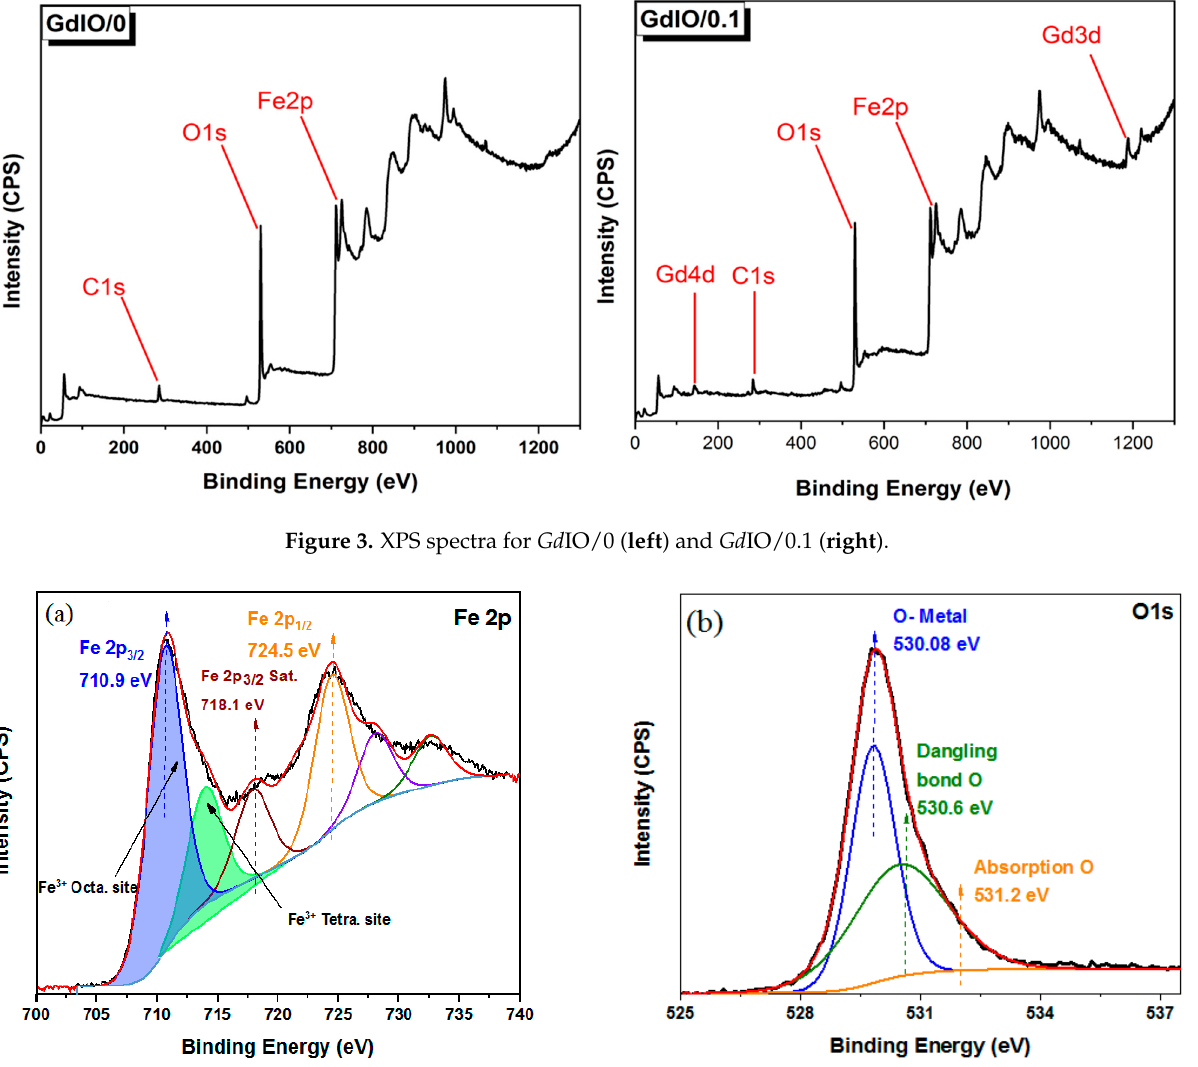
Figure 4. High resolution XPS for sample Gd IO/0 showing ( a ) the iron ion peak, and ( b ) the oxygen peak.